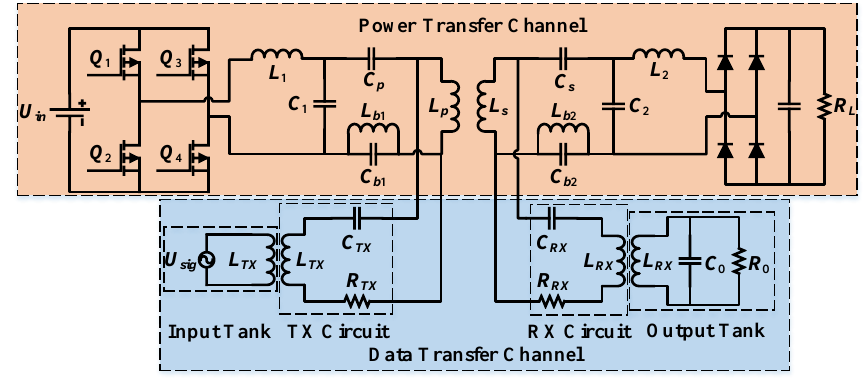
Figure 2. Simultaneous wireless power and data transfer (SWPDT) system with parallel connection The working frequency of the inverter is ω p . The LCC compensation network consisting of L 1 , C 1 and C p ( L 2 , C 2 and C s ) is chosen to be applied in this paper for its characteristic to keep the coil current constant and good performance to reduce the interference of power channel on data transfer channel. At the end of the LCC compensation network, a band-stop network consisting of a parallel LC network consisting of L b 1 and C b 1 ( L b2 and C b2 ) is connected with the coupling mechanism to block the power flow from covering up the data voltage. The center frequency of band-stop network is the data carrier’s frequency ω d .